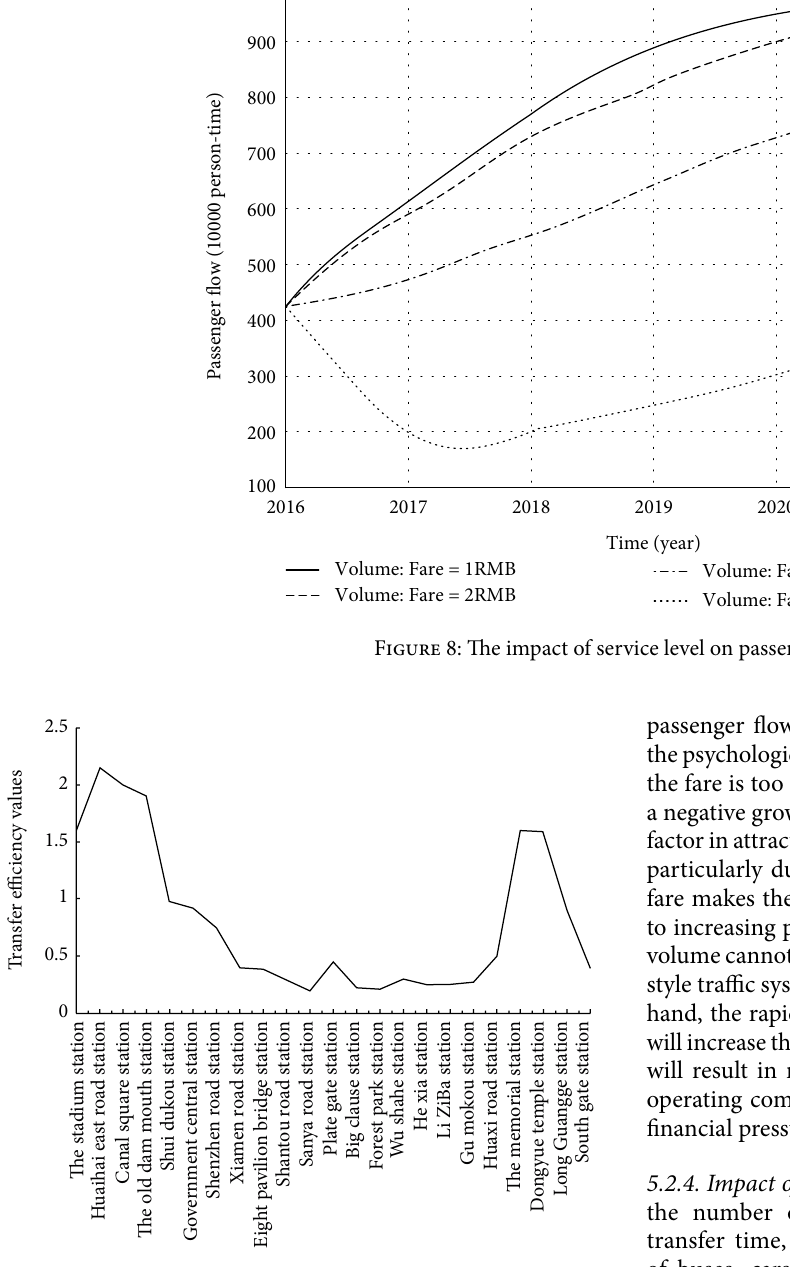
Figure 9: Transfer efficiency values for each